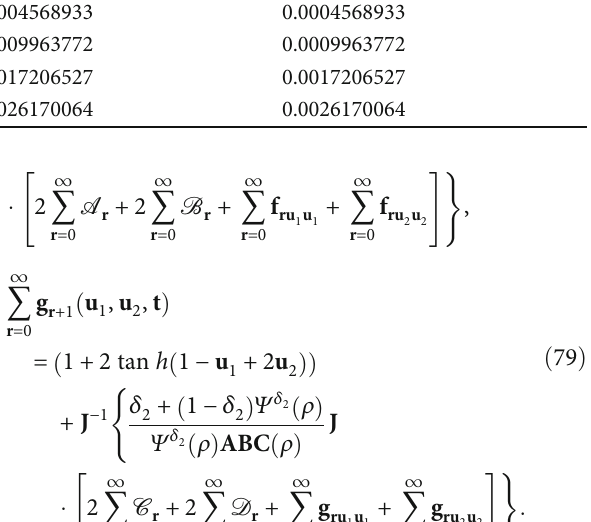
Table 4: The comparison study among VIM [16], JTDM error E abs = k E exact − E approx k at δ 2 = 1 considering multiple values of u 1 and t : u